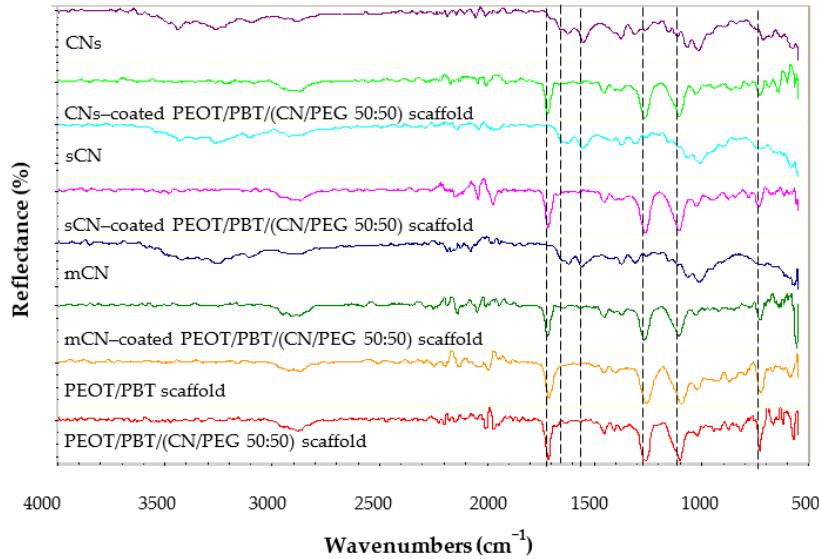
Figure 3. Fourier-transform infrared spectroscopy (FTIR) spectra of pristine CNs from different sources, namely CNs (from crustaceans by Texol s.r.l.), sCNs (from shrimps, by Celabor s.c.r.l.), and mCNs (from mushroom by Celabor s.c.r.l.) in powder form, and PEOT/PBT or PEOT/PBT/ (CN/PEG) scaffold surface coated with electrosprayed CNs from different sources.